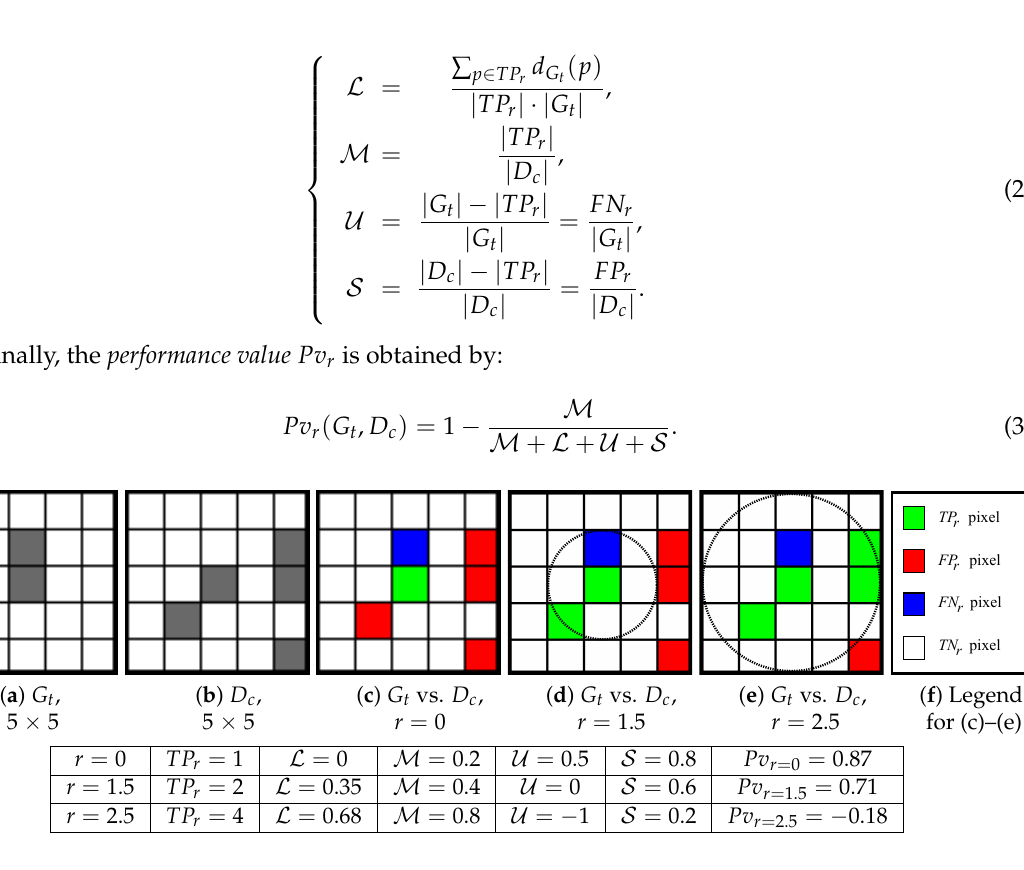
Figure 5. Pv evaluation depends on the r parameter and can produce a negative evaluation. The variable r is represented by the radius of the circle in ( c – e ). The higher the value of r , the higher L and M are and the smaller U and S are (or can become negative for U